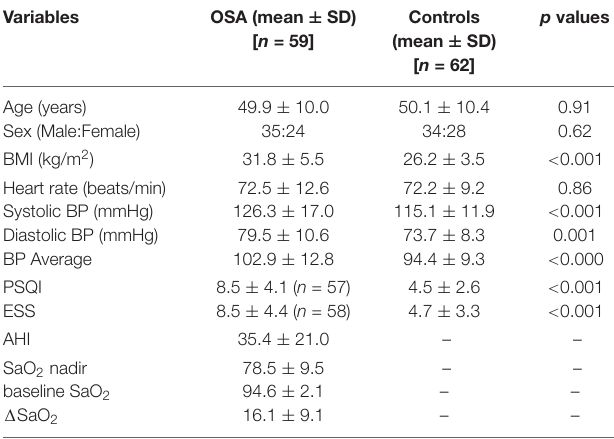
TABLE 1 | Demographics and clinical variables of OSA and control